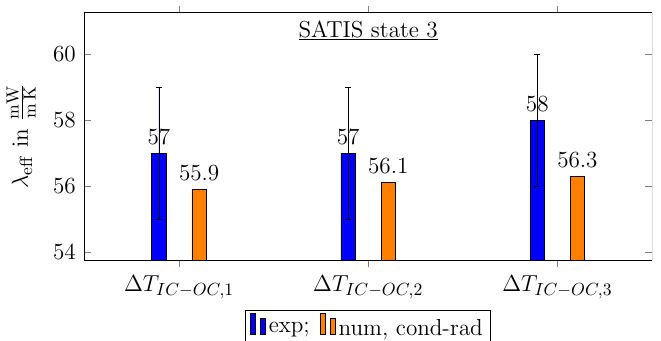
Figure 9. Experimentally (exp) and numerically (num) determined effective thermal conductivities ( λ eff ) of the SATIS panel in state 3 for the temperature differences listed in Table 1 taking into account the physical heat transport phenomena of heat conduction (cond) and thermal radiation